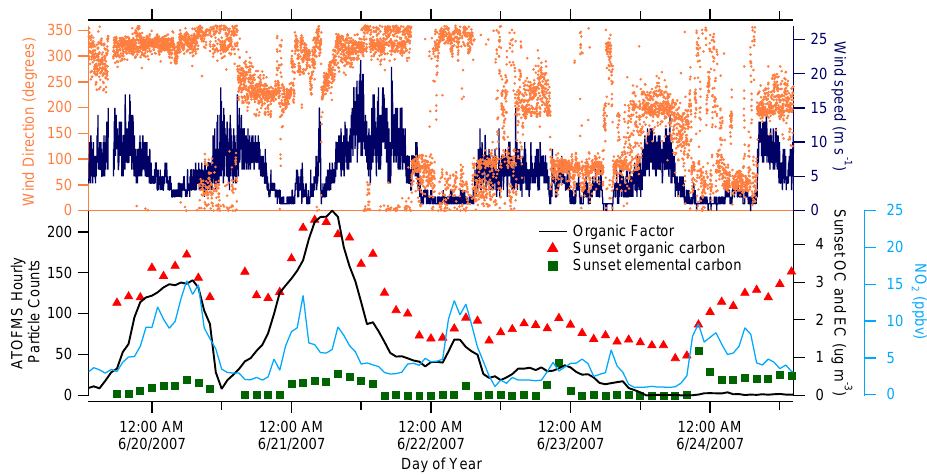
Fig. 8. Temporal trend of the Organic factor in relation to the hourly average NO 2 mixing ratio and Sunset organic carbon and elemental carbon mass concentrations. Only the first few days of the study period when this factor’s concentrations were high are shown.